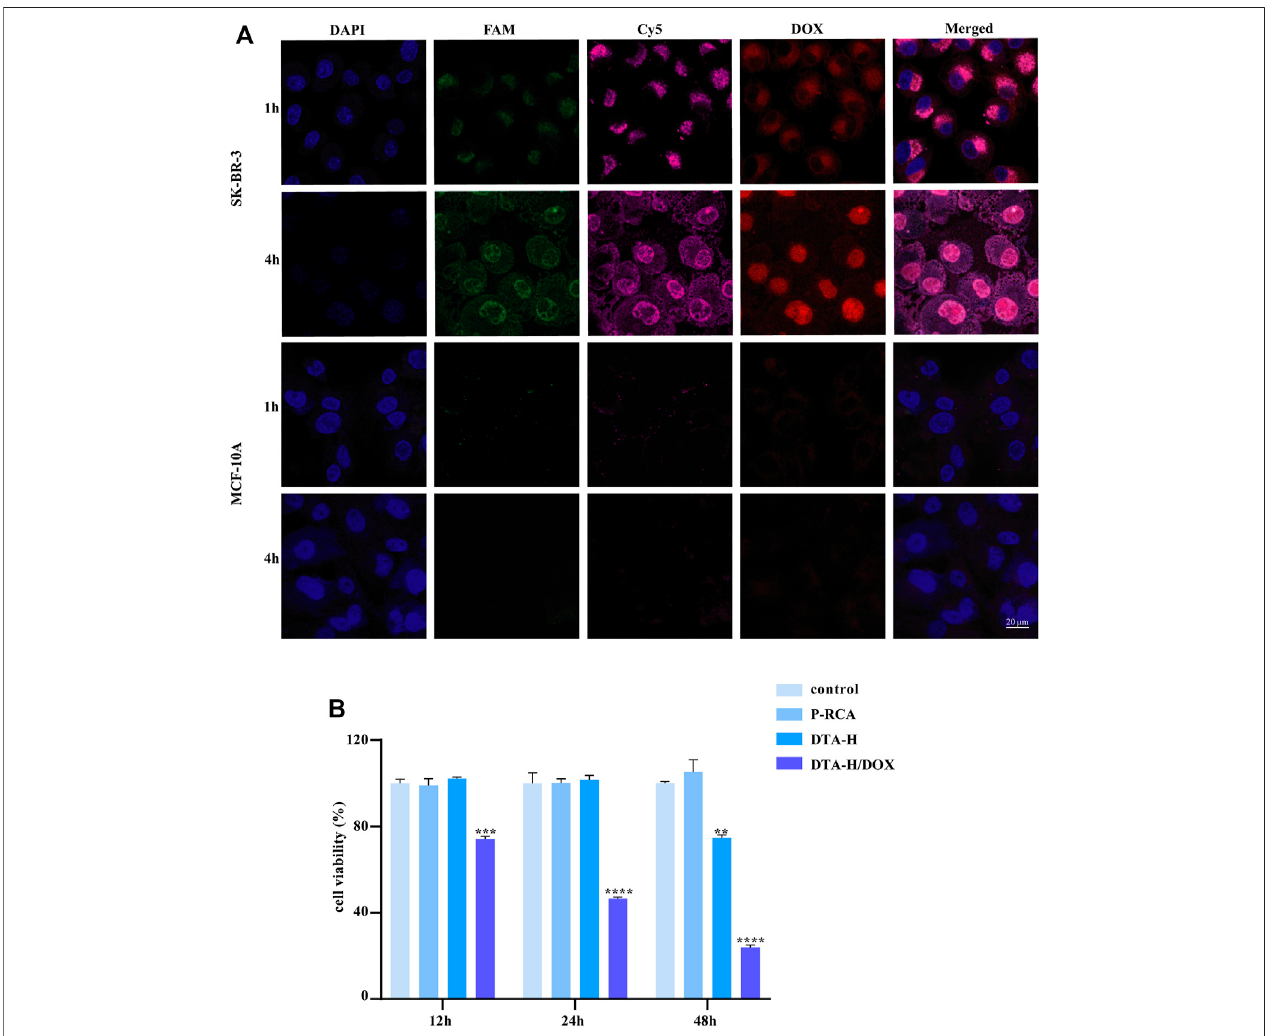
FIGURE 2 | Targeted drug delivery by DTA-H and selective cytotoxicity of DTA-H/DOX. (A) Confocal laser images of SK-BR-3 and MCF-10A cells. Scale bar: 20 μ m. (B) Cytotoxicity pro fi les of P-RCA, DTA-H, and DTA-H/DOX. Error bars denote standard deviations from three independent experiments. Statistical analysis: ** p < 0.01 vs. control; *** p < 0.001 vs. control; **** p < 0.0001 vs.